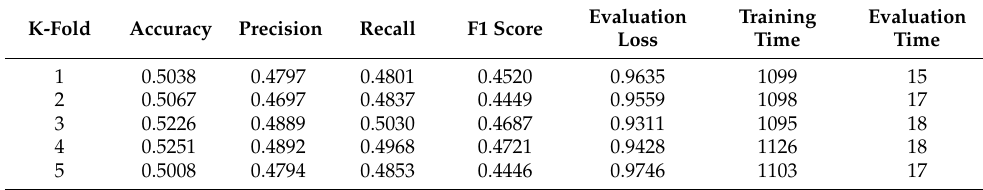
Table 17. DistilBERTimbau—PorSimples Corpus dataset.